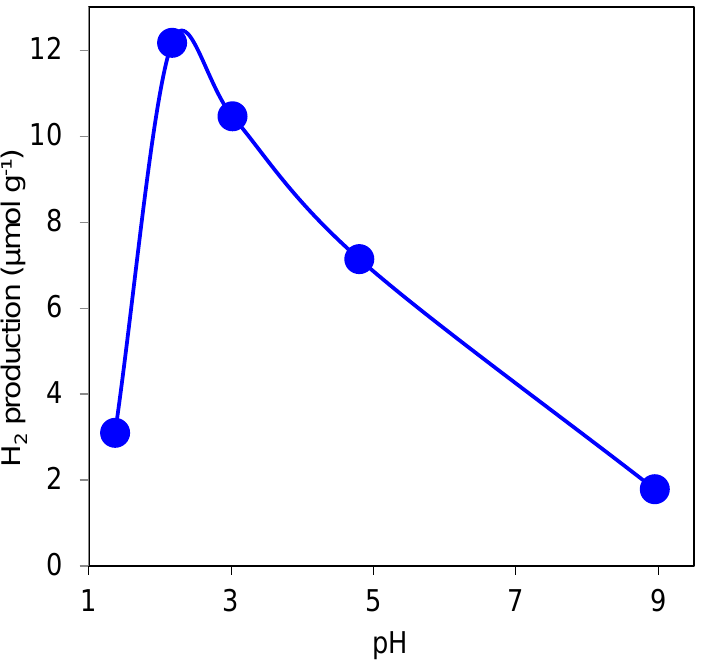
Figure 4. Effect of pH. TiO 2 , 50 mg; Rh, 1.25 ppm; reaction time, 3 h; reaction temperature, 50 °C; formic acid concentration, 1 wt%.